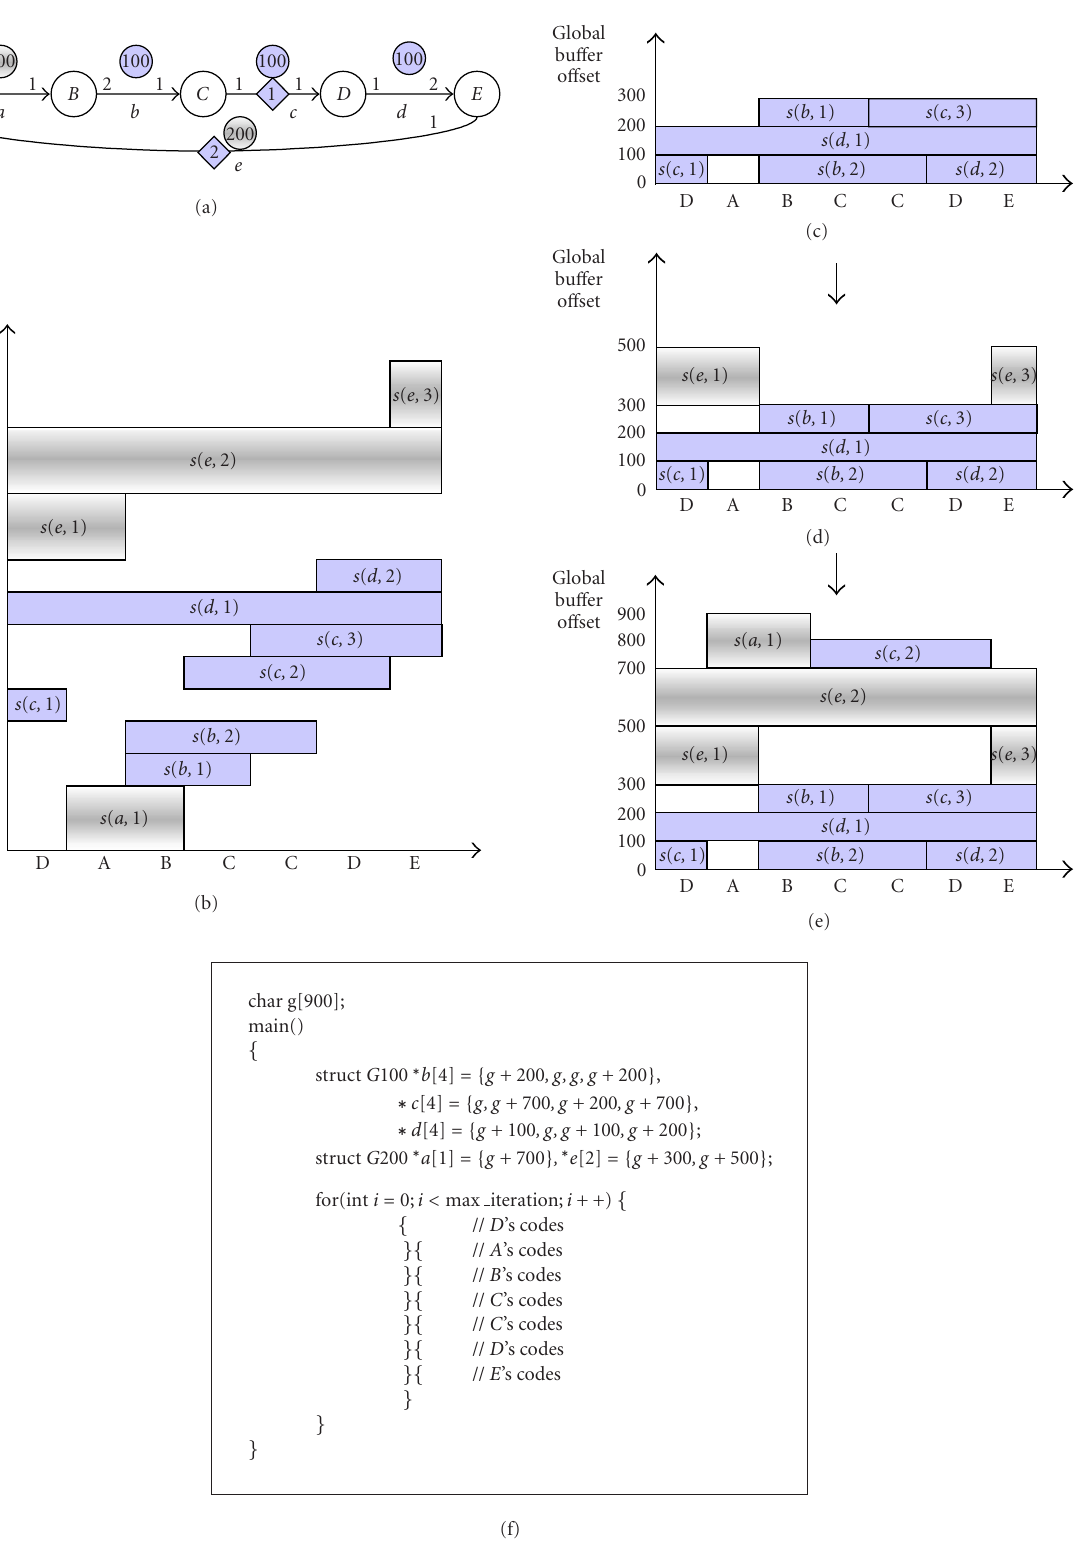
Figure 18: (a) A graph with samples of di ff erent sizes and delays, (b) a sample lifetime chart, (c) LOES placement of samples whose size is 100, (d) LOES placement of samples whose size is 200, (e) LOES placement of the remained samples without delay, and (f) a generated code with static